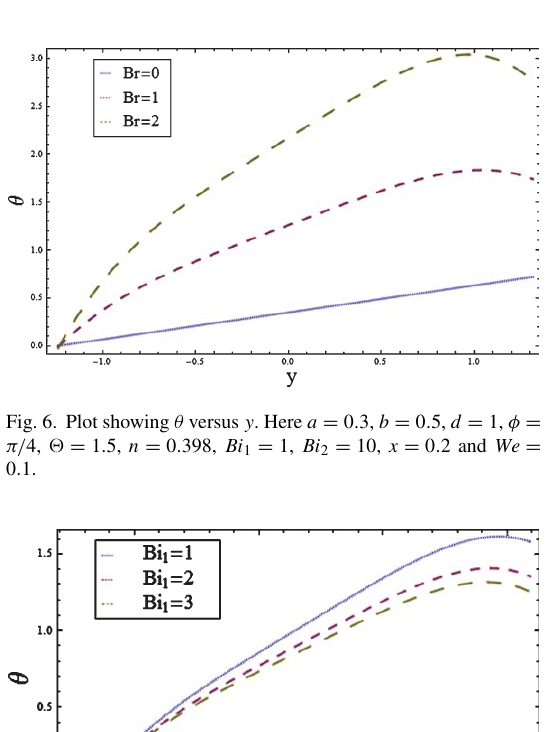
Fig. 4. Plot showing u versus y . Here a = 0 . 6, b = 0 . 3, d = 1 . 1, (cid:14) = 4, n = 0 . 398, x = 0 . 25 and We = 0 . 4.